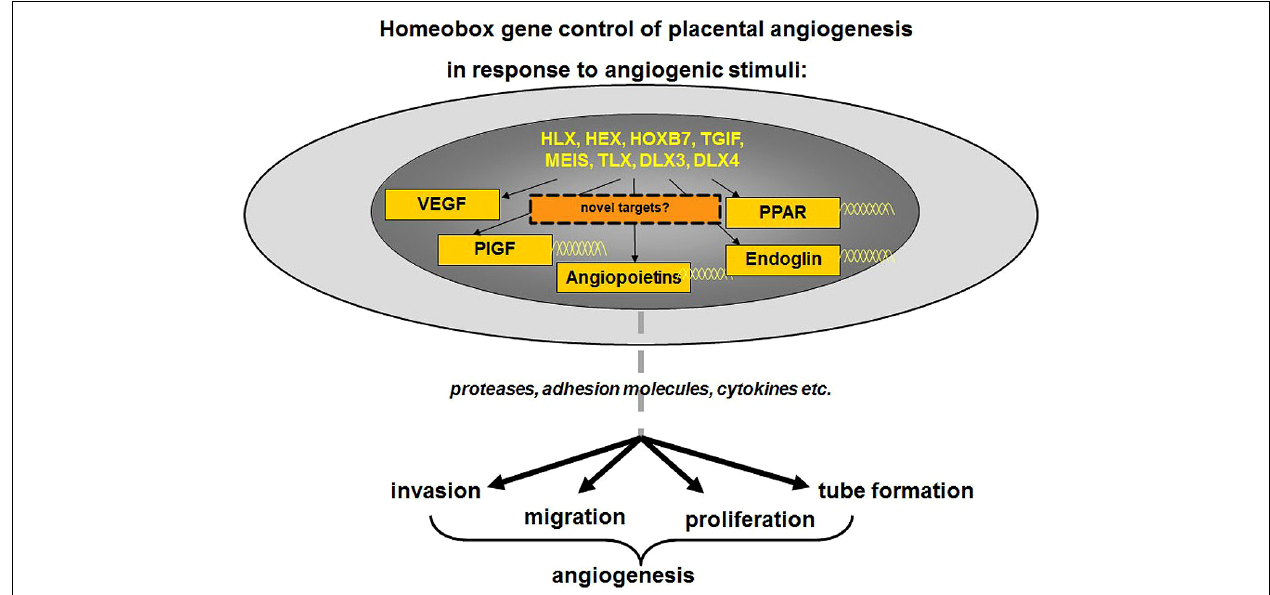
may regulate genes responsible for cell adhesion, migration, proliferation, growth arrest, and the expression of cytokines needed for extracellular matrix interactions all of which are functions characteristic of the angiogenic phenotype. Figure adapted and modified from Sato